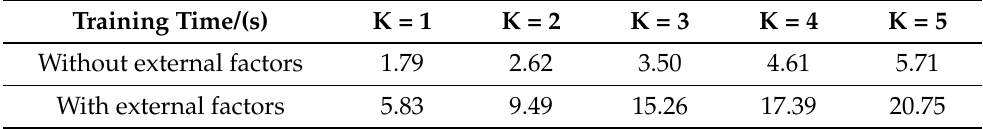
Table 5. The HGCNInf training time of different orders.